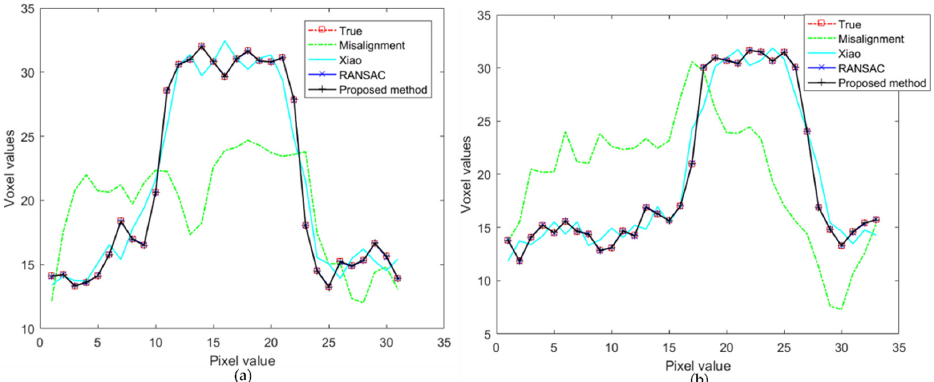
Figure 5. Comparison results of voxel values in red line position in Figure 4. ( a ) The pixel value corresponding to the (I) position in Figure 4. ( b ) The pixel value corresponding to the (II) position in Figure 4.